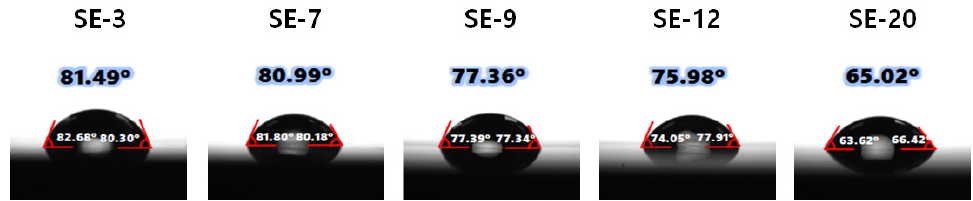
Figure 7. Images of measured contact angles for various specimens after 1 min of degreasing at 80 °C.